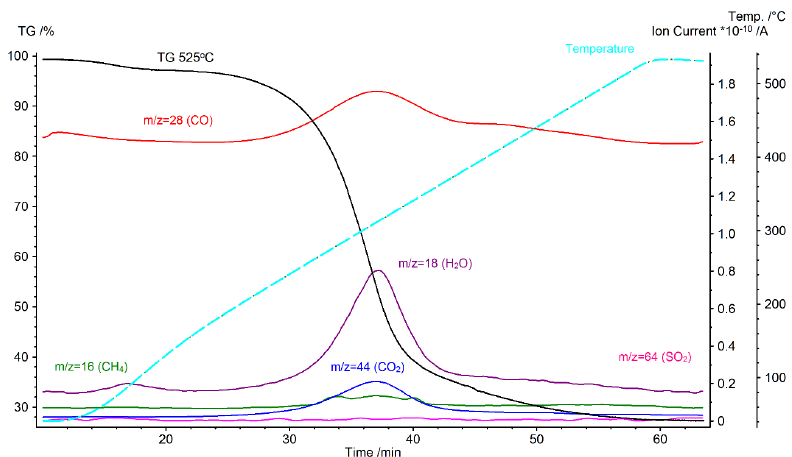
Figure 18. TG curve and ion current curves for the oat straw torrefaction process carried out up to 525 °C.